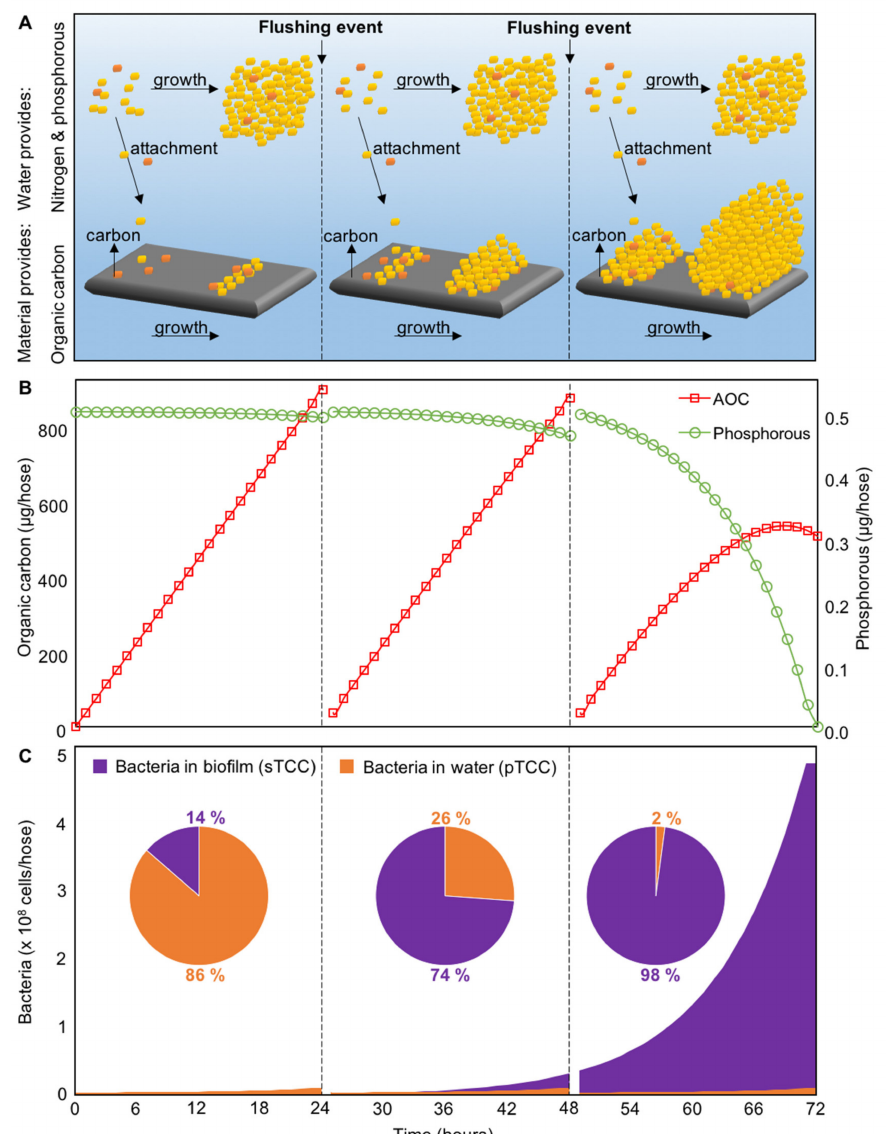
Figure 4. Theoretical example of initial biofilm formation on a new flexible synthetic polymeric material (e.g., PVC-P shower hose). ( A ) Visualization of the initial stages of biofilm formation, driven by attachment (water-to-surface dispersal) and (nutrient-based selective) growth. ( B ) Nutrient concentrations with phosphorous deriving from the water and assimilable organic carbon (AOC) migrating from the material. ( C ) Quantification of bacterial growth, showing rapid domination of the biofilm in the overall distribution of